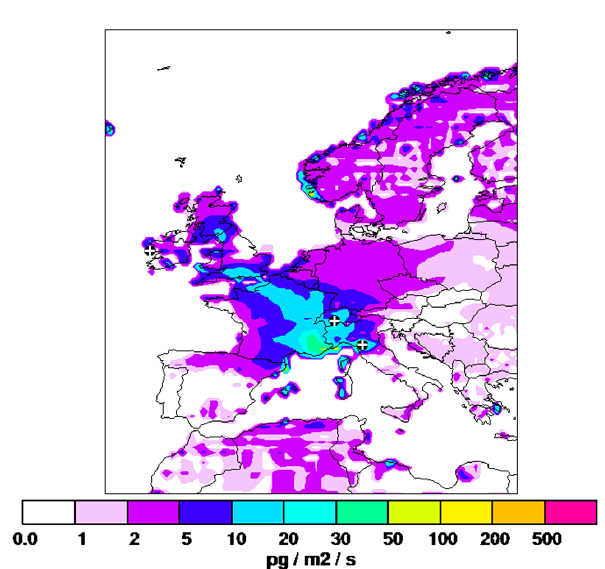
Figure B1. A posteriori study domain emissions in pgm − 2 s − 1 of MCF based on measurements at three European sites and using the BI-1 inversion. Reference period: January–December 2008. White crosses over black dots indicate the locations of the measurements sites.